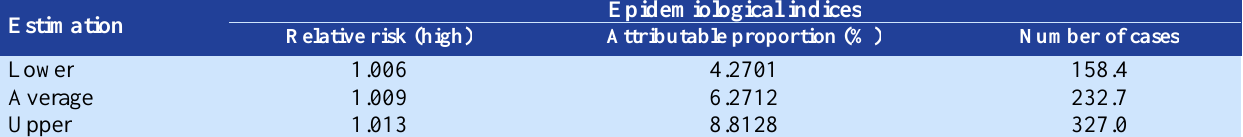
Table 4. The estimation of relative risk indices, attributable proportion, and number of cases of cardiovascular diseases attributed to PM10 (outpatient treatment) (BI = 436) in Kermanshah in 2011